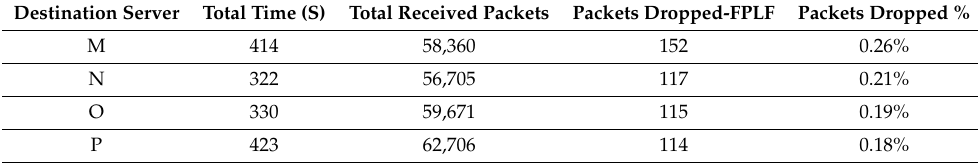
Table 8. Number of dropped packets for the FPLF